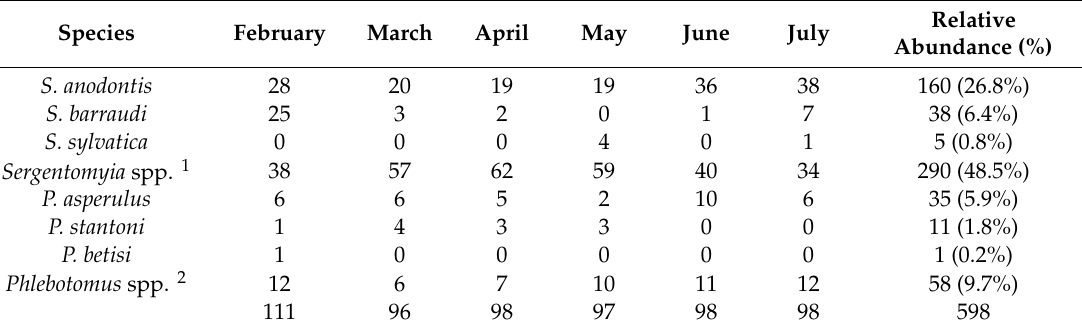
Table 2. Monthly distribution and relative abundance of sandfly species.